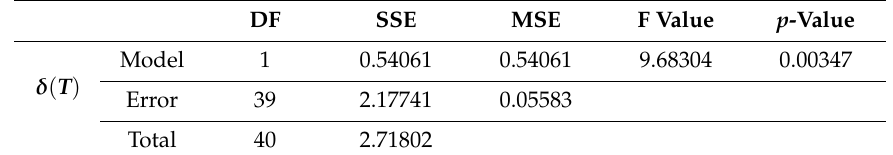
Table 2. ANOVA table for δ ( T ) model indicating that non-zero slope value hypothesis cannot be